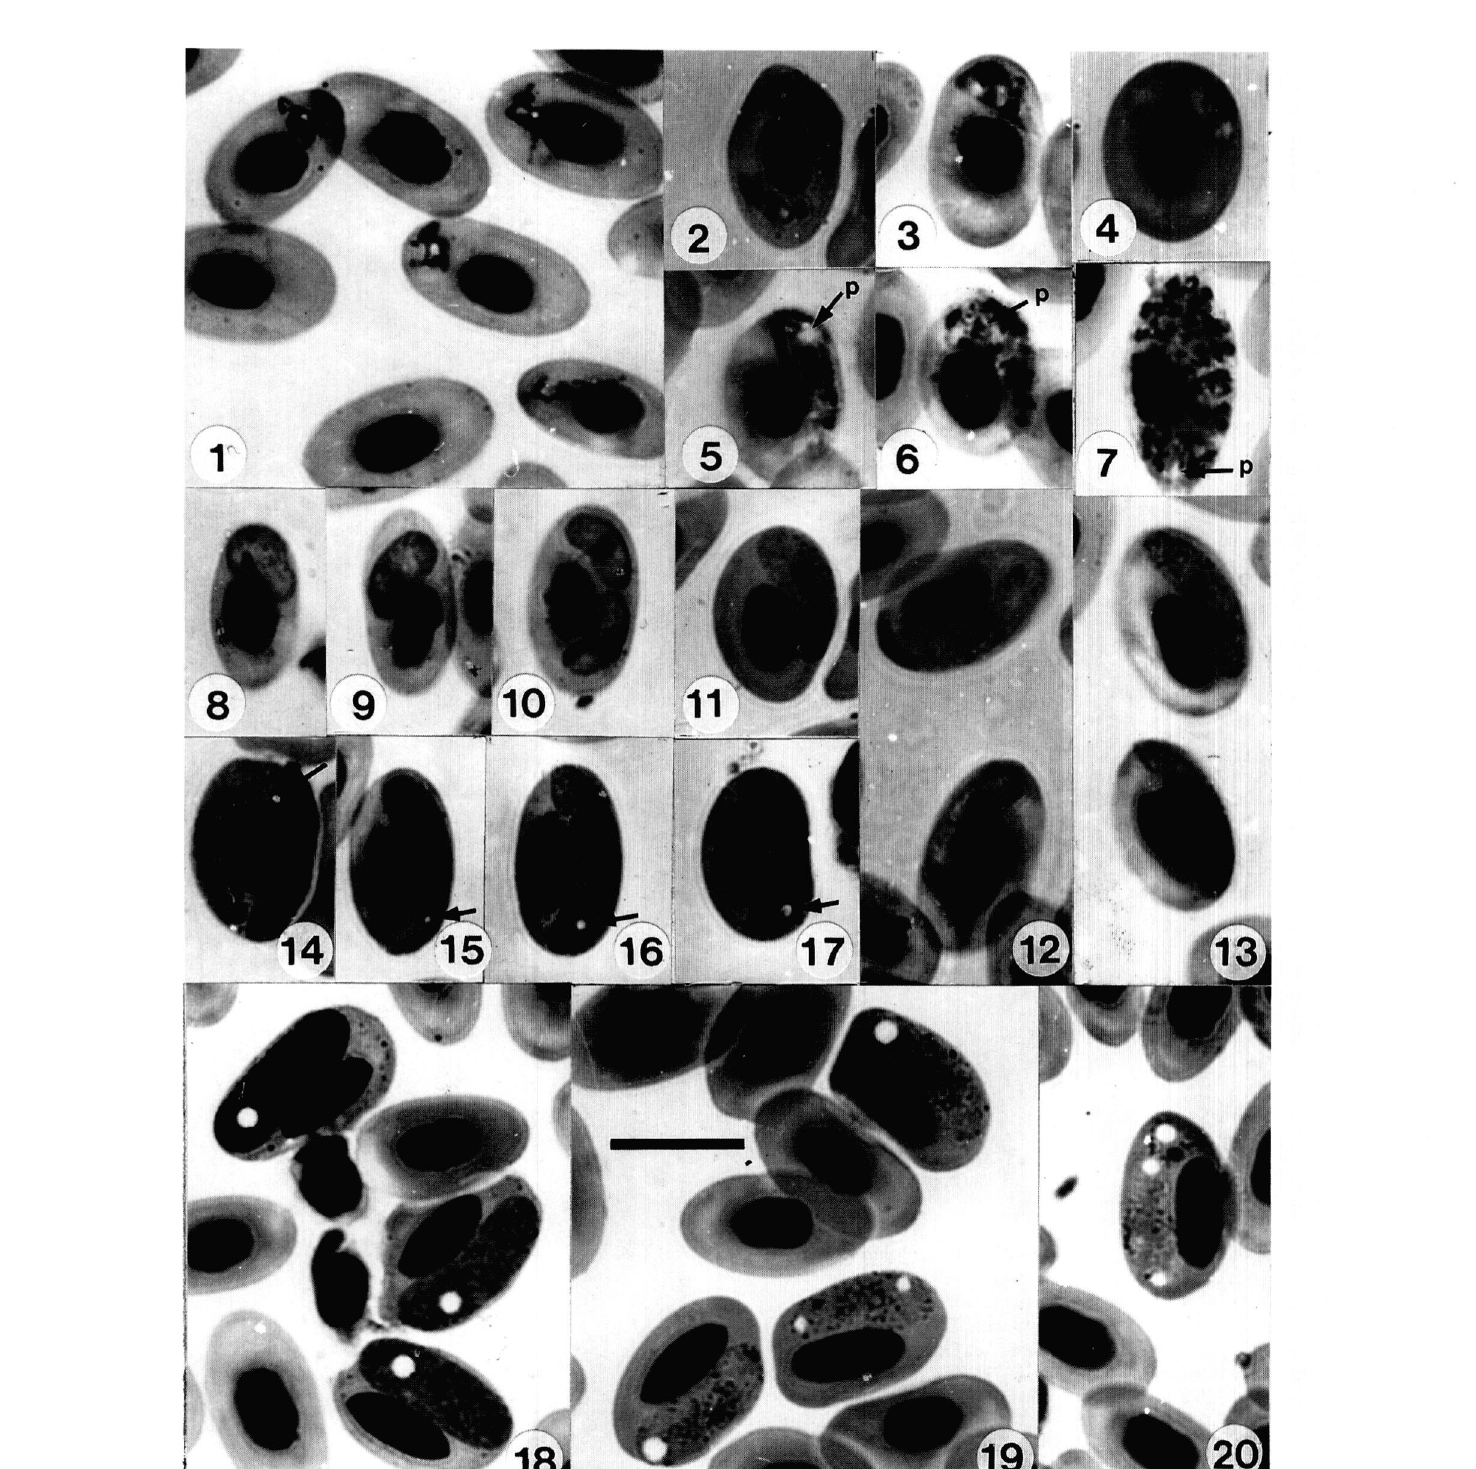
Figs 1-20. - Photomicrographs of Plasmodium kentropyxi n.sp. in the lizard Kentropyx calcarata. Fig. 1. Amoeboid trophozoites. Fig. 2. Multiple infection of an erythrocyte with three young meronts. Figs 3-6. Growth of developing meronts round the host cell nucleus from a polar to a lateral position: p = pigment, clustered in a cytoplasmic vacuole. Fig. 7. Two well developed meronts in a single erythro­ cyte. Figs 8-13. Growth of developing gametocytes from a polar to a lateral position in the erythrocyte: these young forms have yet to develop a cytoplasmic vacuole. Fig. 14. Young male (left) and female (right) gametocytes in the same erythrocyte. Figs 15-17. Progressive development of the vacuole (arrows) in a male (left) and two female gametocytes. Fig. 18. Mature female gametocytes with fully deve­ loped vacuoles. Figs 19-20. Mature male gametocytes with fully developed vacuoles. Note the tendency of males to produce one, two or even three vacuoles. Bar - 10 µm, and applies to all Figs. Giemsa staining.